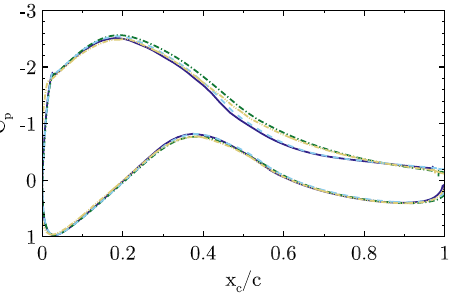
Figure 32. Pressure coefficient at r/R = 0 . 136. CaseT1.0 (solid), CaseT1.0-rounded (dashed), CaseT1.0-fairing (dashed- dot), CaseT1.0-dYm05 (dashed dot